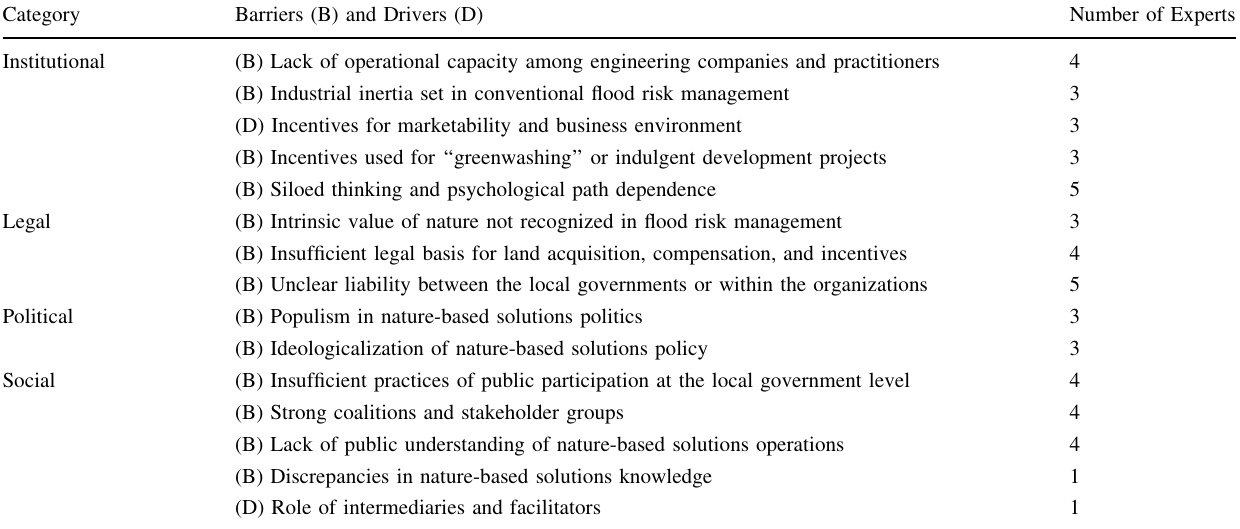
Table 4 Contextual barriers and drivers for mainstreaming of nature-based solutions (NBS) in South Korea